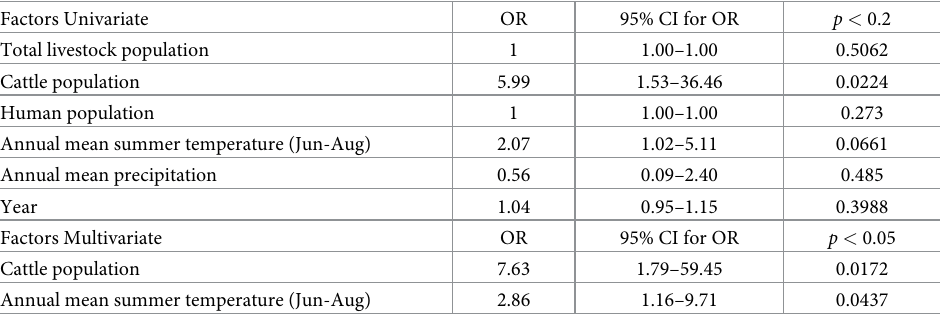
Table 3. Factors potentially associated with a large anthrax outbreak occurrence by univariate and multivariate logistic regression: Cases (large > 51 � small) vs .